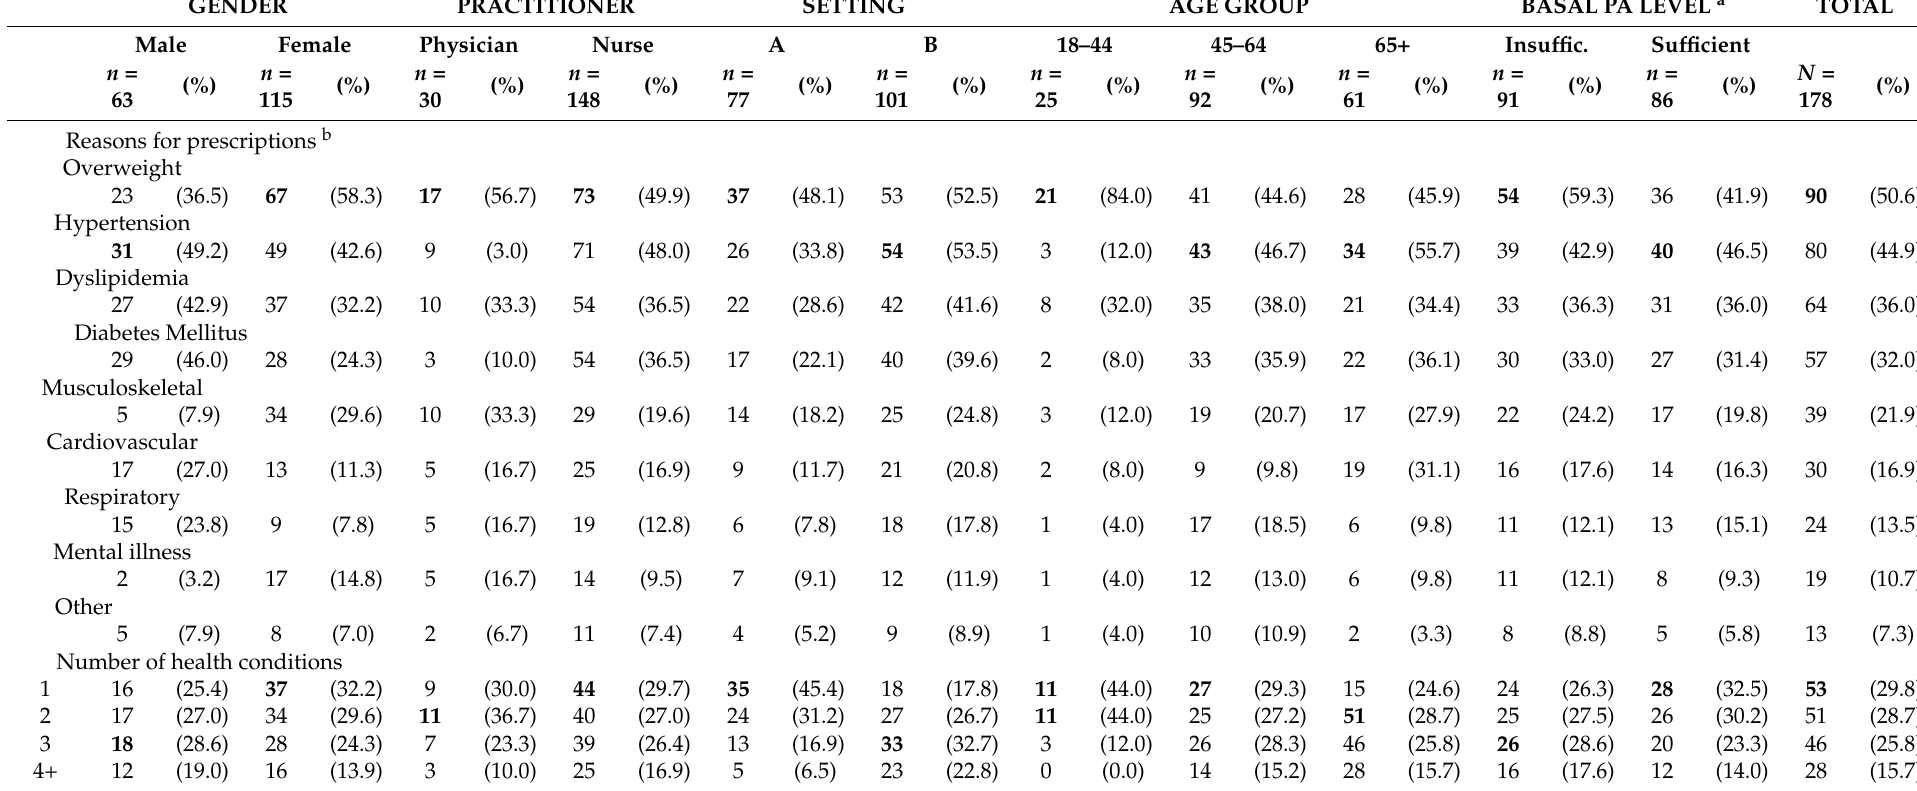
Table 2. Participants grouping and reasons for